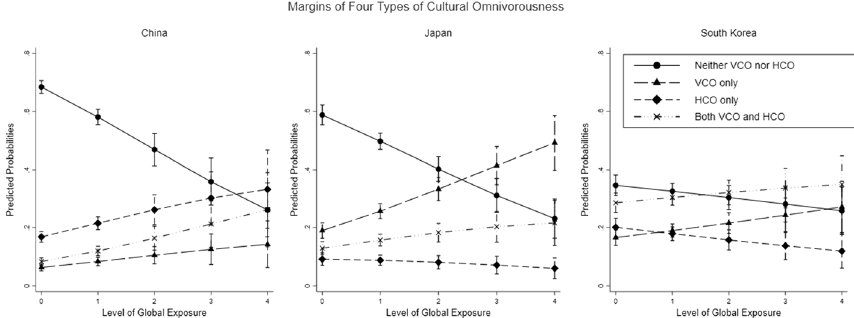
Fig. 4 Predicted correlation between global exposure and types of cultural omnivorousness in China, Japan, and South